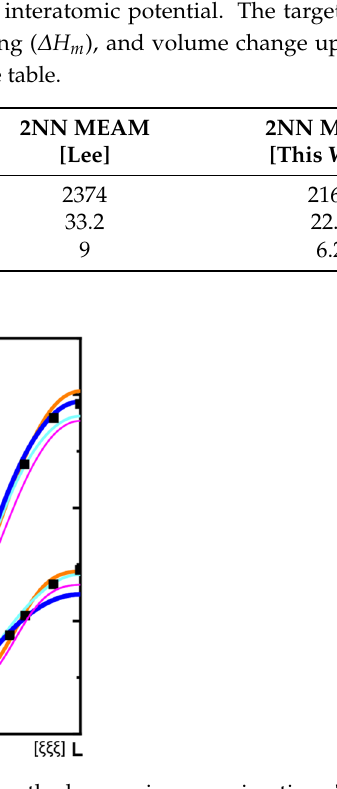
Figure 2. Phonon spectra of fcc Pt predicted based on the harmonic approximation. The spectra obtained from the experiment [88], the present DFT calculation, and the present and previous [69] 2NN MEAM potentials are compared.